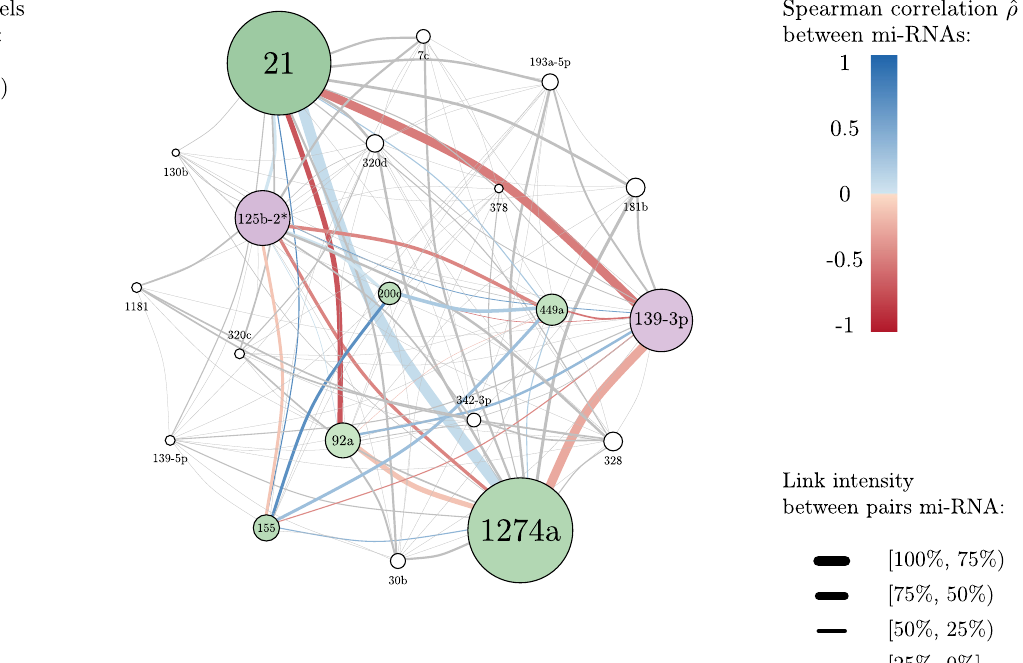
Oncogenic or protective role of miRNAs: the syntagmatic axis. The values of the single and asso- ciative coefficients of the eight most frequently selected miRNAs are displayed in Fig. 7 and Table 3. Coefficients related to miRNAs that are present in at least 10% of models and that show discordant values between single and associative β s are presented in Table 4. Among the eight most frequently selected miRNAs, the median value of the β s considered along with their range makes it possible to identify three classes of miRNA (cf. Fig. 7 and Table 3): (i) oncogenic miRNAs with single and associative positive values of β ( hsa-miR-1274a, miR-139-3p, hsa-miR-125b-2* ); (iii) an undefined miRNA ( hsa miR-92a ) with a negative single coefficient and a positive associative one. An indication of the consistency of these results lies in the Spear- man correlation coefficients ˆ ρ (cf. Fig. 5): hsa-miR-1274a is significantly positively correlated (at the level α = 5% ) to its oncogenic partner hsa-miR-155 and negatively correlated to protective miRNAs hsa-miR- 125b-2* and hsa-miR-139-3p . The same consistency can be observed for hsa-miR-21 . The two pro- tective miRNAs, hsa-miR-139-3p and hsa-miR-125b-2* , are also significantly positively correlated with each other, and significantly negatively correlated to oncogenic miRNAs such as hsa-miR-449a and hsa-miR-1274a .